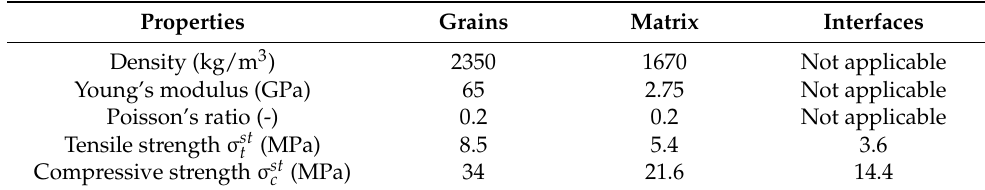
Table 1. Initial values of mechanical characteristics of mesoscale